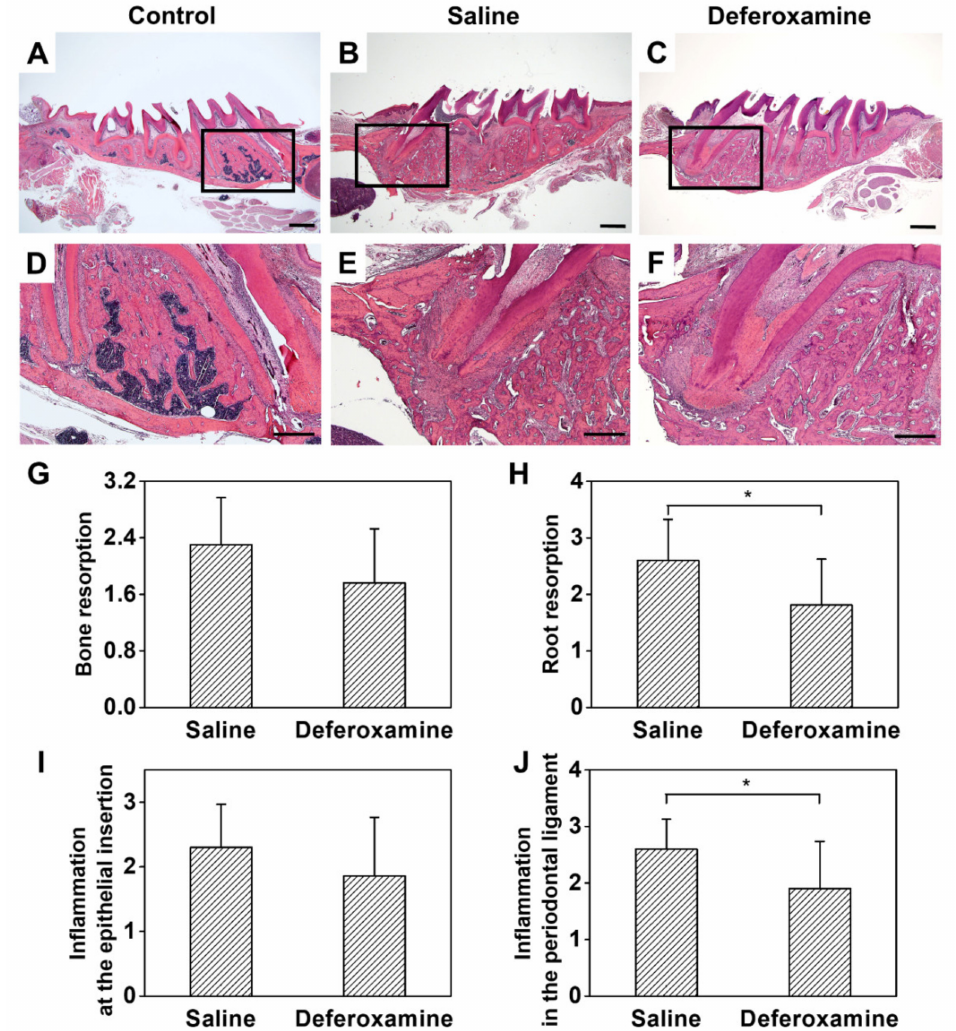
Figure 5. Histological analysis of rat maxillary first molars 4 weeks after replantation. ( A , D ) Control groups: The teeth without extraction and replantation. Normal root surface and alveolar socket. ( B , E ) Saline groups: Many cells related with inflammation were observed in the periodontal liga- ment space, severe inflammatory root resorption was found on all surfaces of the root. ( C , F ) DFO groups: Localized root resorption in the apical third happened. ( G – J ) Evaluated scored, expressed as mean ± standard deviation, for ( G ) bone resorption, ( H ) root resorption, ( I ) inflammation at the epithelial insertion, and ( J ) inflammation in the periodontal ligament in the saline and DFO groups. Hematoxylin–eosin staining, Mann–Whitney U test, * p < 0.05 (applies to G – J ). Scale bars: ( A – C ): 1 mm, ( D – F ): 500 µ